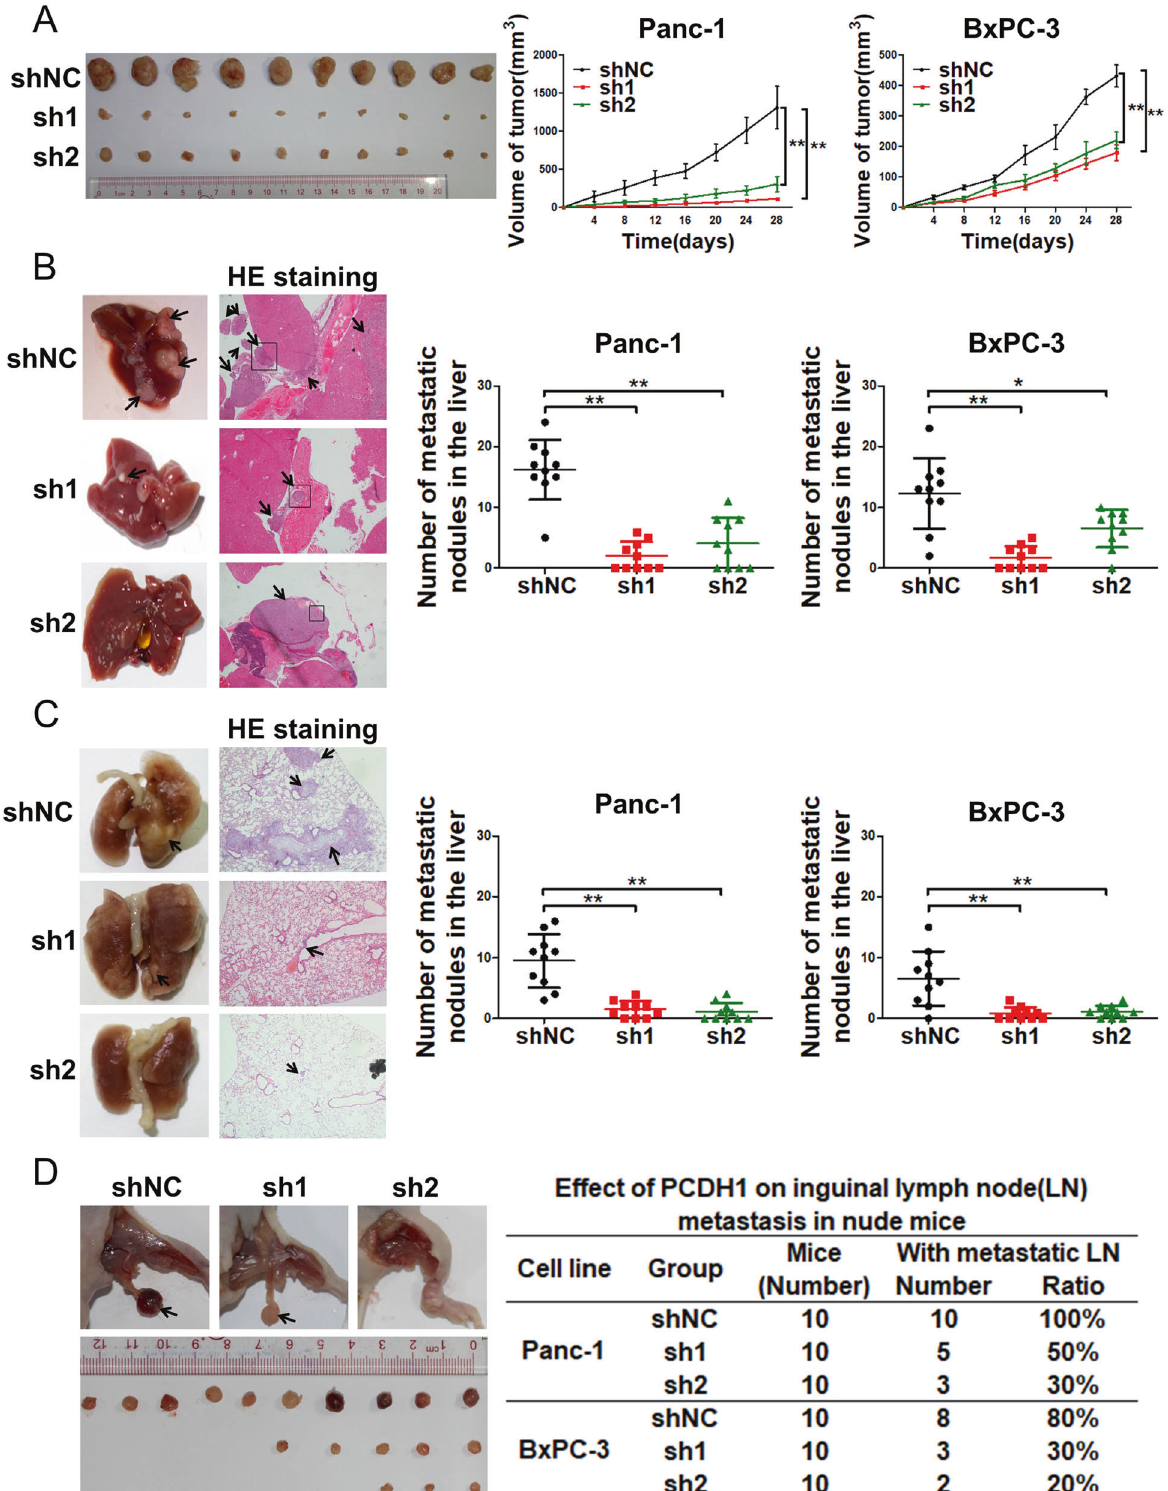
into the spleens of nude mice, as reported previously [20]. Silencing PCDH1 expression resulted in a signi fi cant reduction in the number of liver metastases (Fig. 3B), and a similar effect was observed with a lung metastasis model (Fig. 3C). As we previously mentioned, PCDH1 expression correlates with lymph